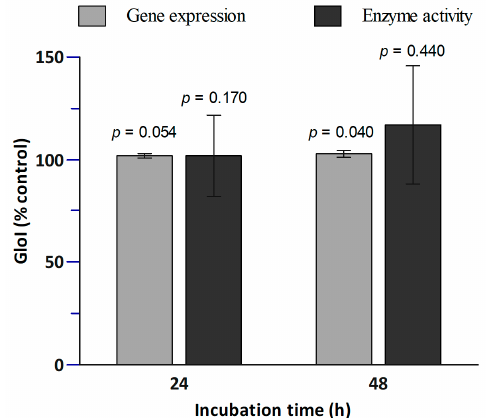
Figure 3. Effect of SR treatment on Glo1 gene expression and activity. PBMCs were treated with 2.5 µ M SR for 24 h and 48 h followed by RT-PCR on Glo1 gene expression and Glo1 enzymatic activity assay. Data are shown as percentage of control: The bars at 24 h represent the expression and activity relative to the control at 24 h without SR, and the bars at 48 h represent the expression and activity relative to the control at 48 h without SR. Each bar represents mean ± SE; n = 8 subjects. The p -values were calculated by comparing the control values with 24 h SR incubation samples, and with the 48 h SR incubation samples.